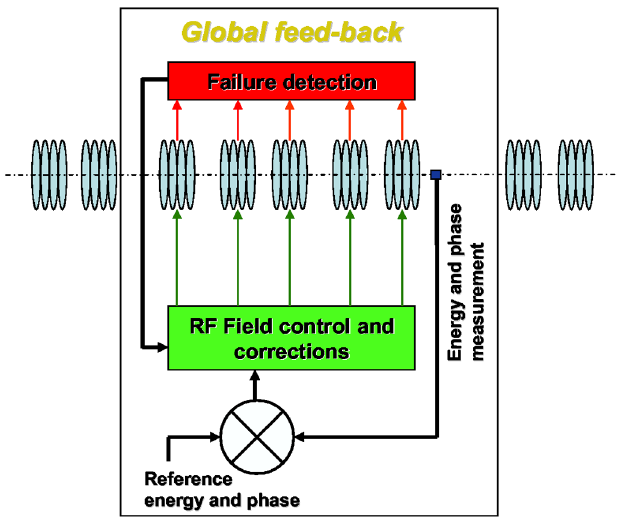
FIG. 1. (Color) Global feedback scheme for rf-fault recovery